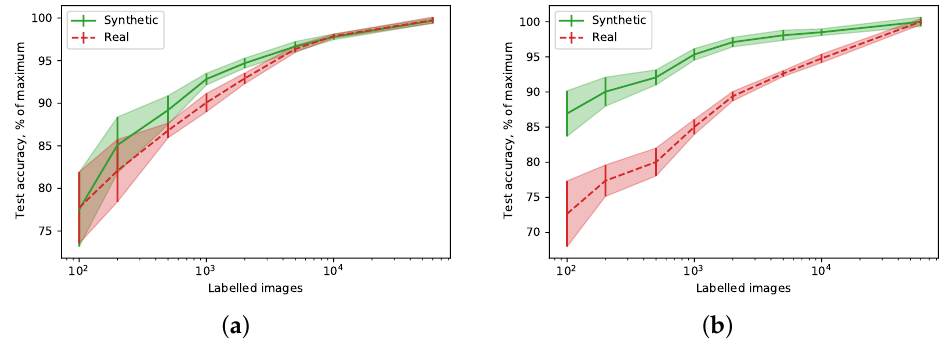
Figure 3. Relative accuracy (a percentage of maximum achievable accuracy) for different numbers of labelled images. ( a ) MNIST; ( b )